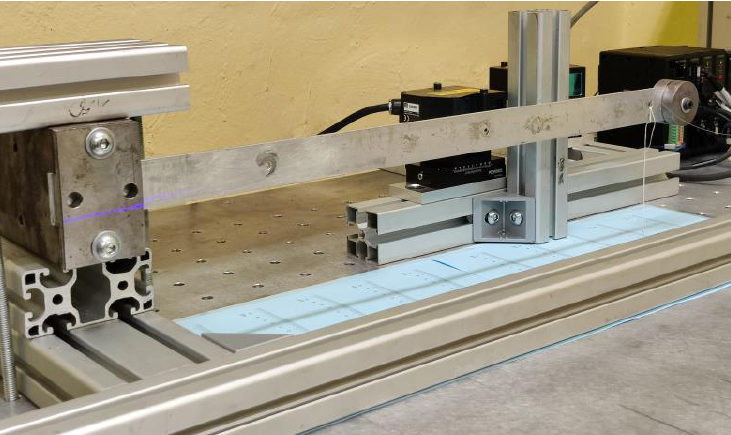
Figure 1. Euler – Bernoulli cantilever beam.